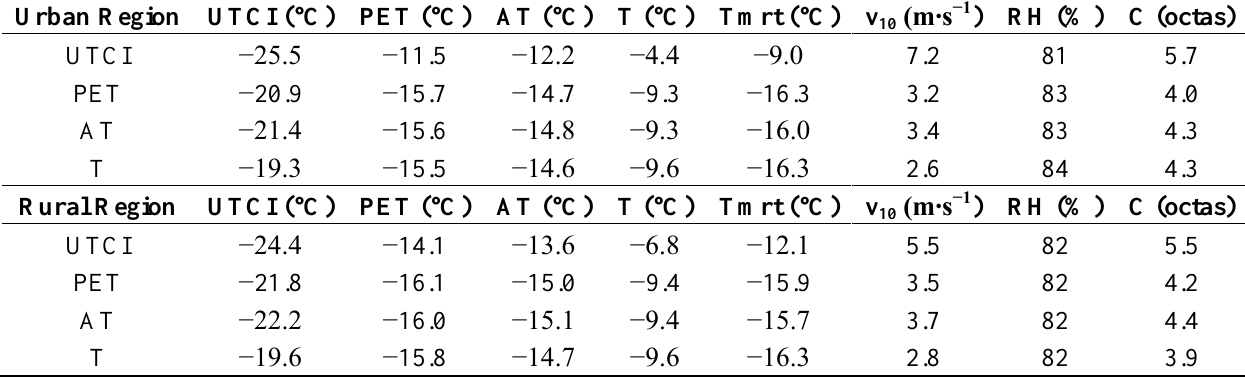
Table 6. Average values of (equivalent) temperature indices and input meteorological variables on cold days identified by individual indices in urban versus rural